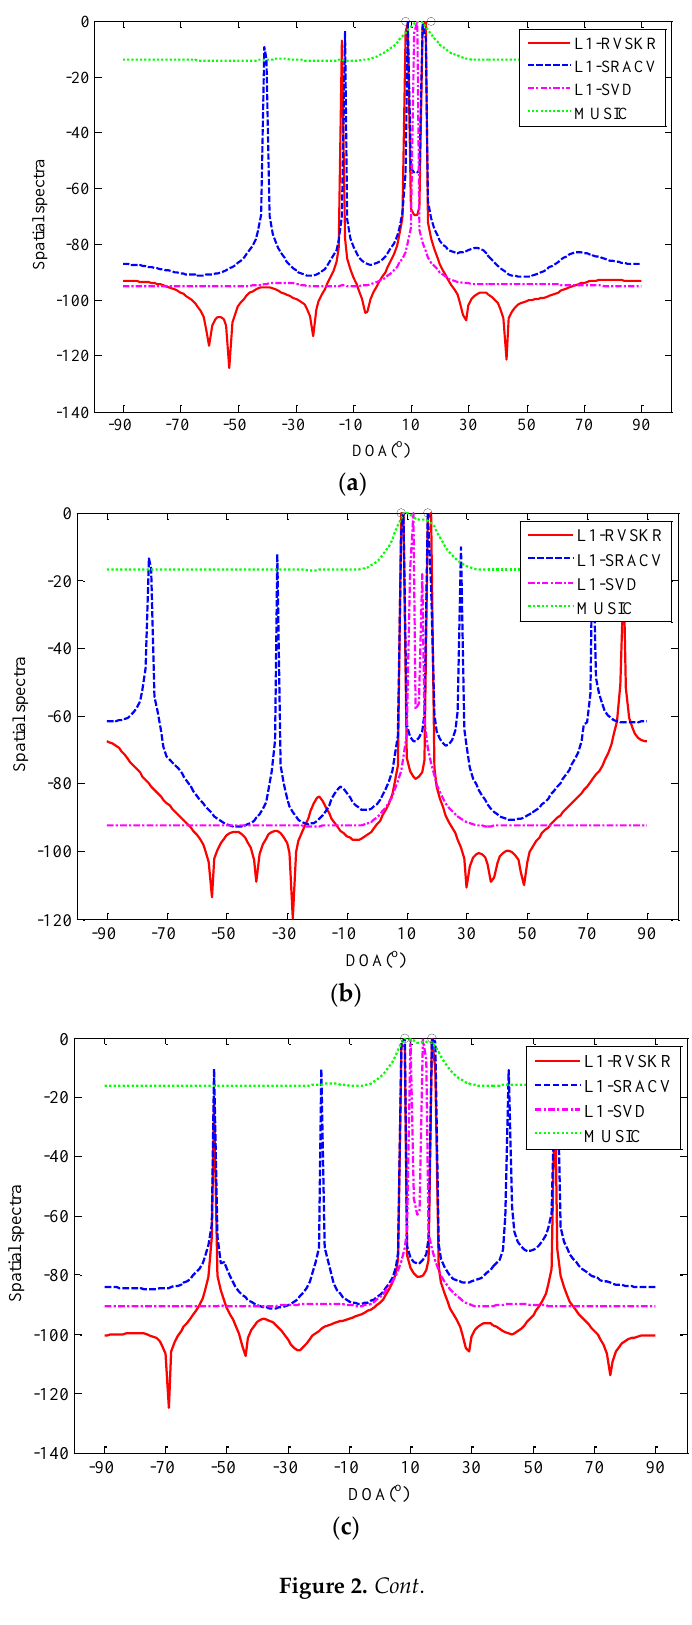
Figure 1. The spatial spectra for four signals with the number of sensors 5 M  , the number of snapshots 500 L  and SNR = 0 dB.